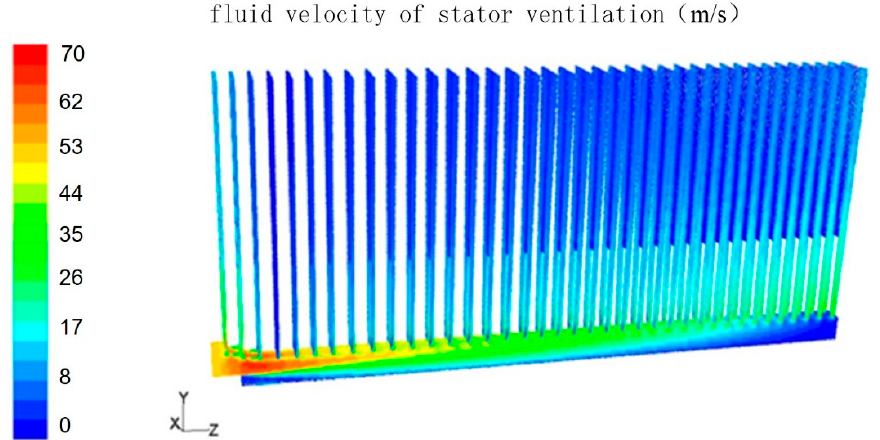
Figure 9. Fluid velocity distribution of stator air gap and the ventilation duct.